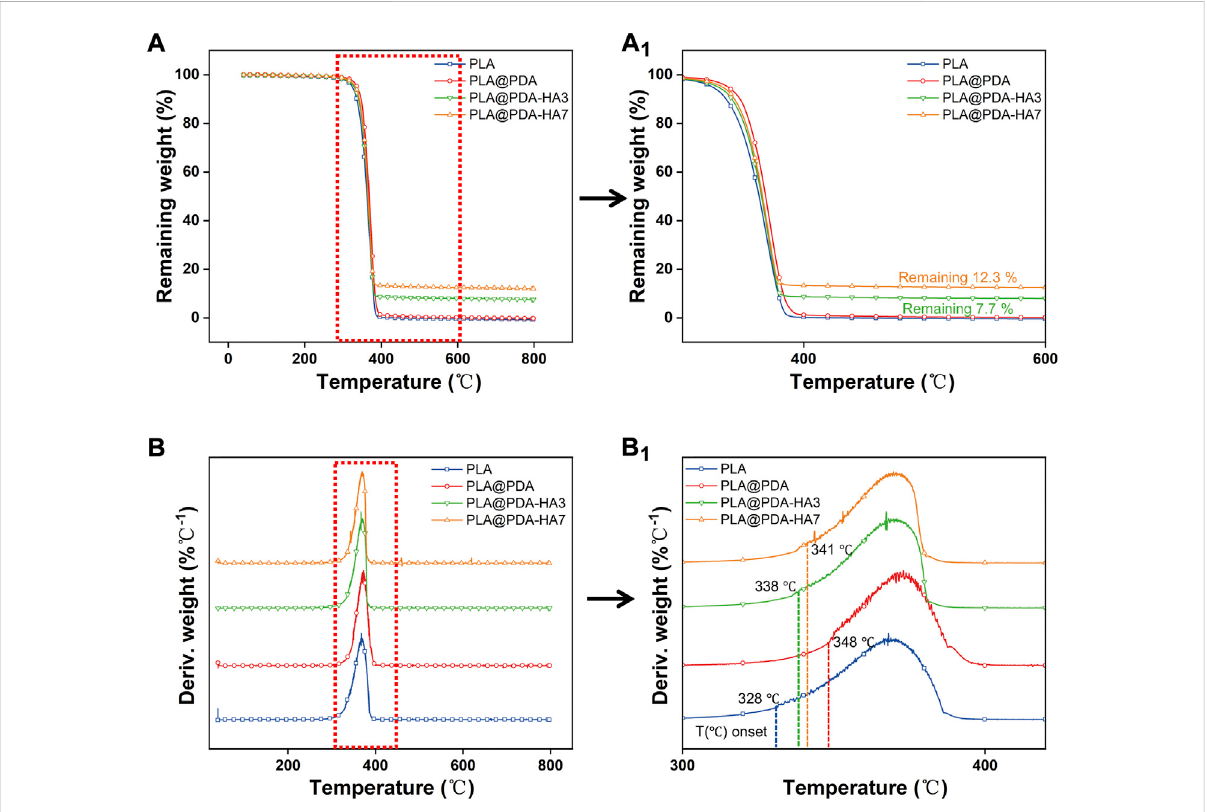
FIGURE 7 Thermal gravimetric curves (TGA) (A) and derivative thermal gravimetric curves (DTG) (B) of PLA, PLA@PDA, PLA@PDA-HA3, and PLA@PDA- HA7 scaffolds. Close-up views of TGA (a 1 ) and DTG (b 1 )